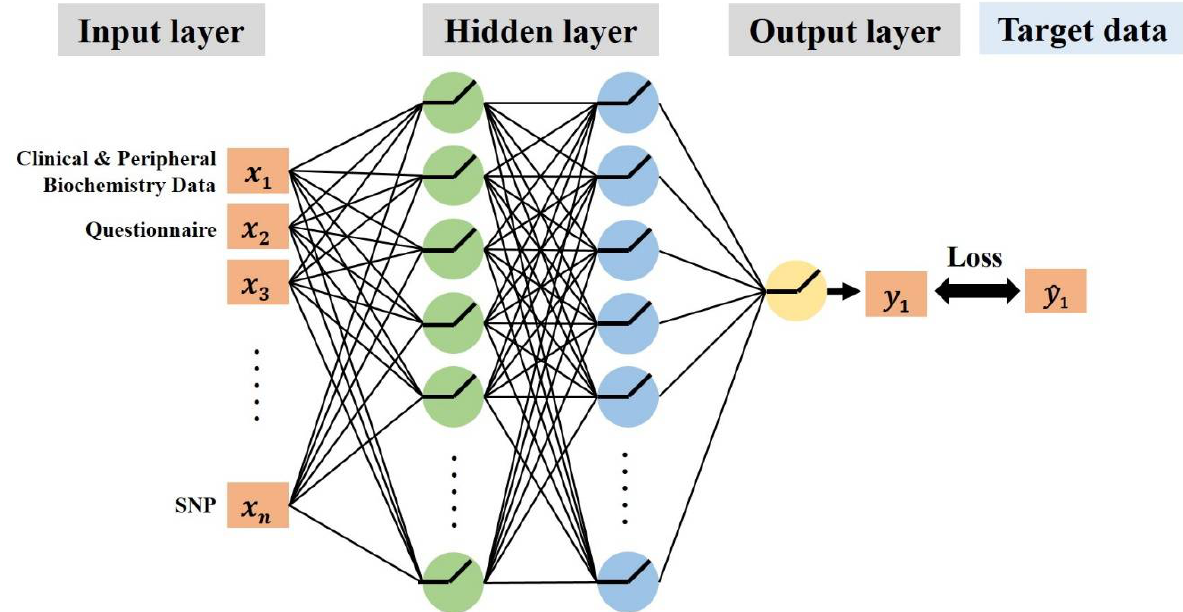
Figure 1. The architecture of the multilayer feedforward neural networks used to predict the treatment outcome.